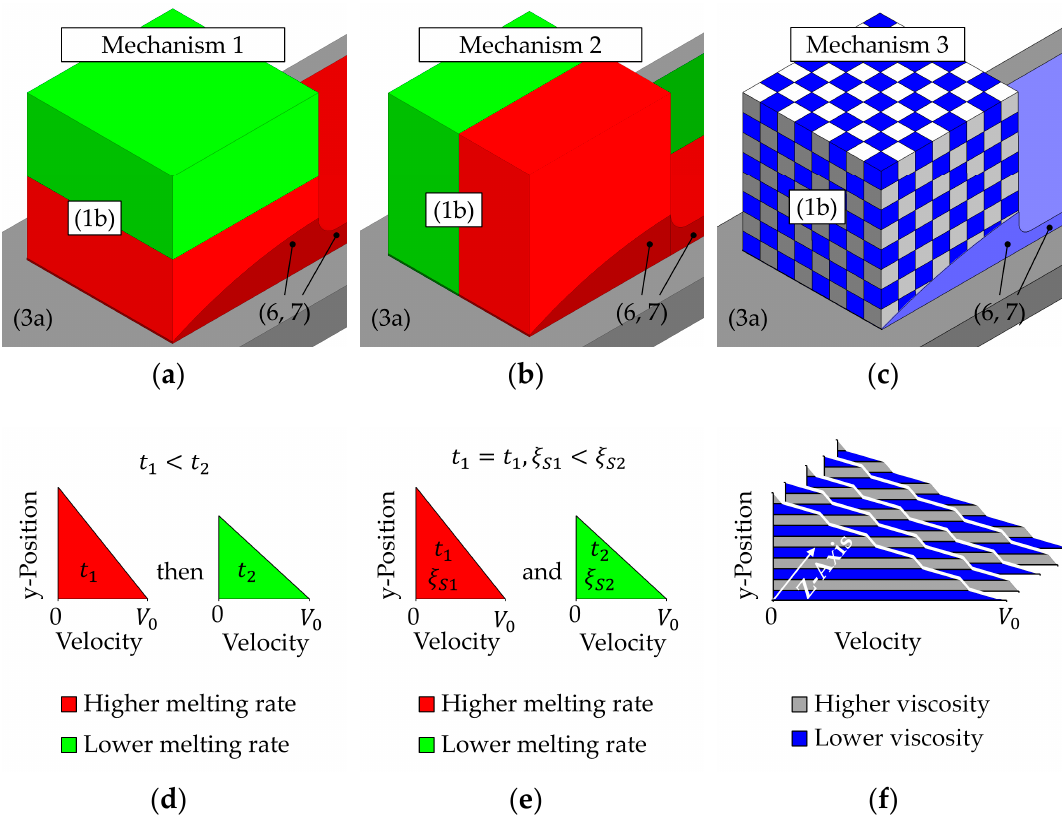
Figure 6. Schematic depiction of the three considered melting mechanisms. The consecutive numbering is consistent to Figure 2: (1b) Solid bulk polymer, (3a) hot moving infinite plate, (6,7) melt film in the sample chamber and outside of it; ( a – c ) schematic arrangement of the materials, ( d – f ) schematic depiction of the velocity profiles. ( a , d ) Consecutively melting of the materials; ( b , e) Simultaneous melting of the materials with homogeneous melt films. ( c , f ) Simultaneous melting of the materials with a layered melt film.